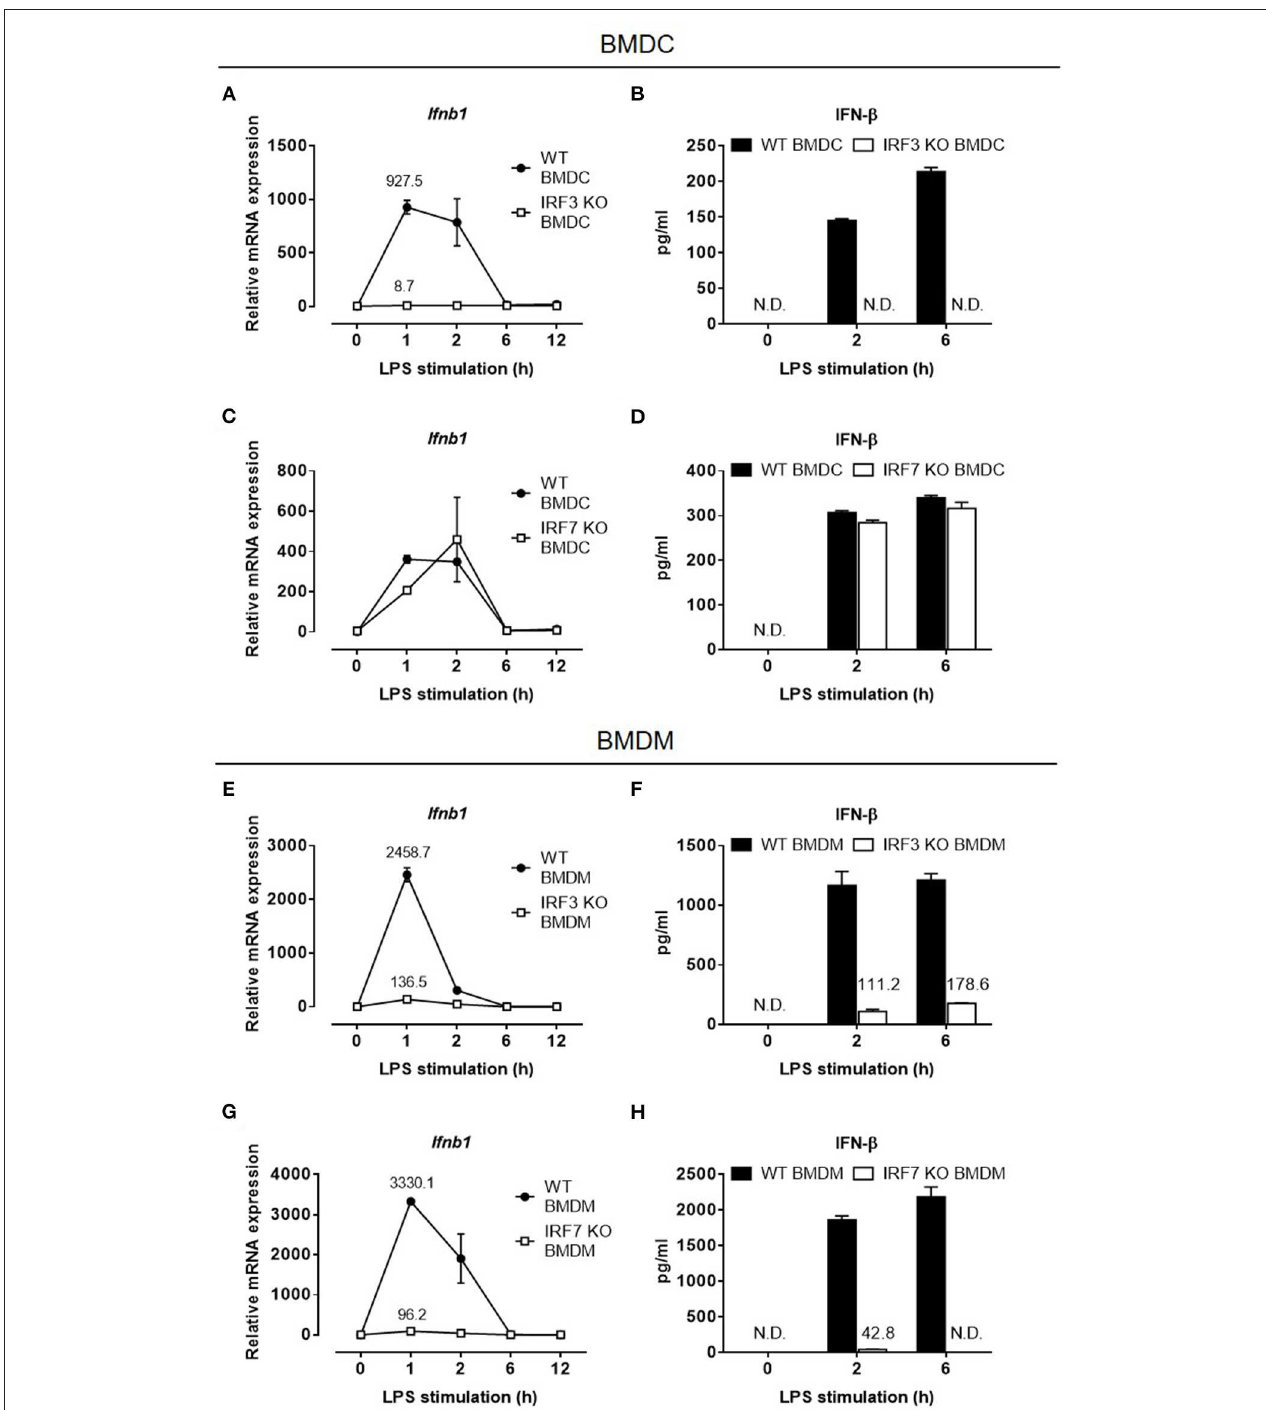
FIGURE 2 | IFN- β expression in LPS-challenged macrophages depends on both IRF-7 and IRF-3, whereas IFN- β expression in LPS-challenged DCs depends on IRF-3 but not IRF-7. (A–D) Real-time PCR and ELISA analysis of IFN- β gene and protein expression of BMDCs from IRF-3 knockout mice (A,B) , and IRF-7 knockout mice (C,D) , together with their respective wild-type control littermates, stimulated or not with 100ng/ml LPS for 0–12h. Ifnb1 expression was normalized to Gapdh, and expressed relative to the levels observed in un-stimulated wild-type control cells. Data are presented as mean ± SD of duplicate determinations from one representative of at least two independent experiments (N.D.: not detected). (E–H) Real-time PCR and ELISA analysis of IFN- β gene and protein expression of BMDMs from IRF-3 knockout mice (E,F) , and IRF-7 knockout mice (G,H) , together with their respective wild-type control littermates, stimulated or not with 100ng/ml LPS for 0–12h. Ifnb1 expression was normalized to Gapdh and expressed relative to the levels observed in un-stimulated wild-type control cells. Data are presented as mean ± SD of duplicate determinations from one representative of at least three independent experiments (N.D.: not detected).